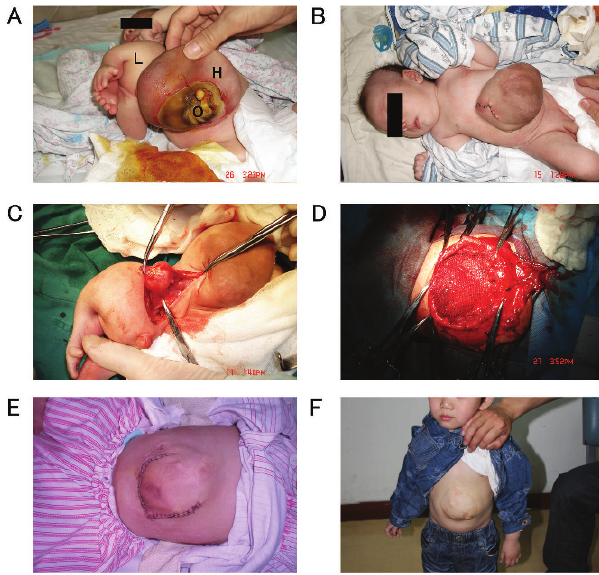
Figure 2 - (A) Large hernia of the abdominal wall (H), omphalocele (O) and limbs (L) of the parasitic twin in case 2. (B) View of the hernia in case 2. The parasitic twin was excised, and the omphalocele was repaired. (C) The pelvis of the parasitic twin in case 2 contained one small kidney and a cyst. (D) The hernia in case 2 was repaired using VYPRO II mesh. (E) Condition of the repaired ventral hernia in case 2 at 14 days after surgery. (F) The autosite in case 2 during the twenty-third month after the operation to remove the parasitic